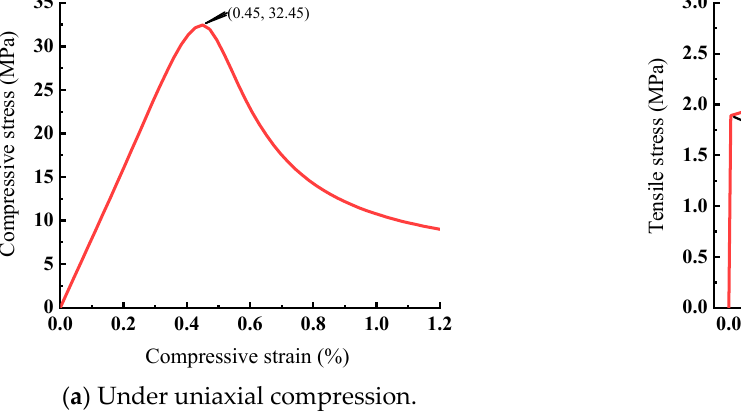
Figure 10. Constitutive relationships of ECC.